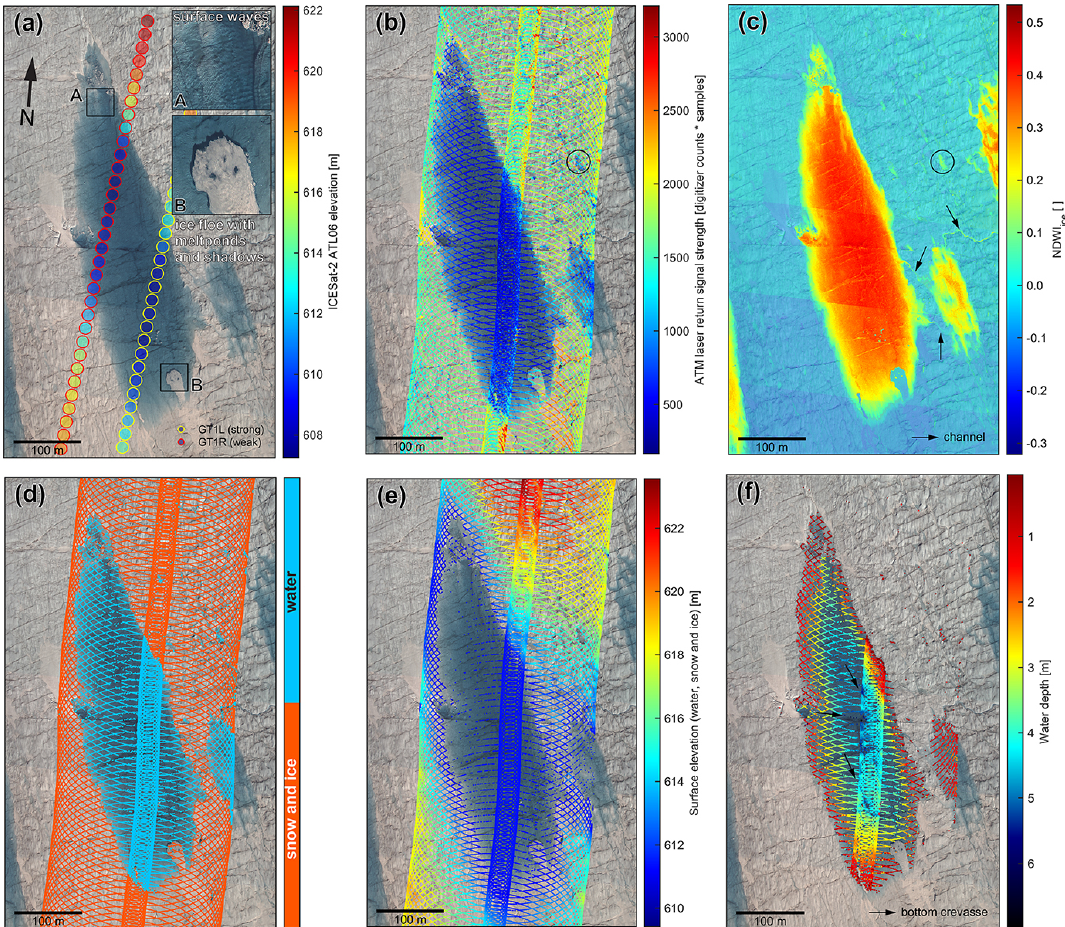
Figure 7. (a) Mosaic of five geolocated, orthorectified CAMBOT natural color (red, green, blue) images of a supraglacial lake. ICESat-2 data (Smith et al., 2021) closest in time and space were acquired on 13 June 2019, 38d after the ATM pass over the lake on 6 May 2019. (b) Return signal strength of the ATM T6 (wide scan) and T7 (narrow scan) laser footprints. The return signal strength is significantly lower over the lake compared to the surrounding snow and ice surface. (c) NDWI ice plotted over CAMBOT image mosaic with NDWI ice pixels below the detection threshold of 0.05 shown at 50% opacity. (d) Surface classification of ATM laser footprints based on NDWI ice pixels using a classification threshold of 0.05. (e) Surface elevation of laser footprints over snow, ice, and water. (f) Water depth of hydrological features. For location see Fig. 2. Surface temperature and surface melt indicator from MODIS (Hall et al., 2018; Hall and DiGirolamo, 2019) and the number of melt days for this location are shown in Fig.